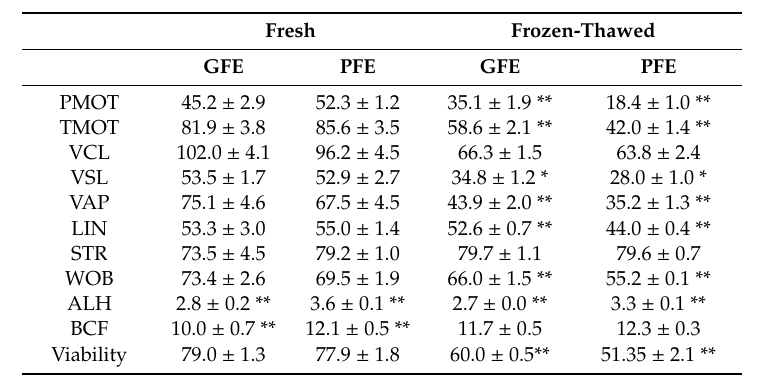
Table 1. Quality parameters (mean ± SEM) of fresh and frozen–thawed semen from good and poor freezability ejaculates ( n =